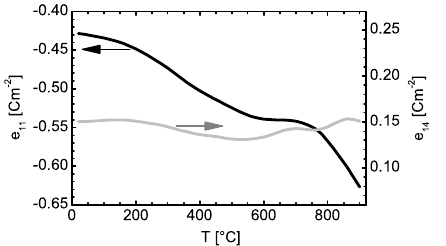
Figure 7. The piezoelectric coefficient of langasite as function of temperature.